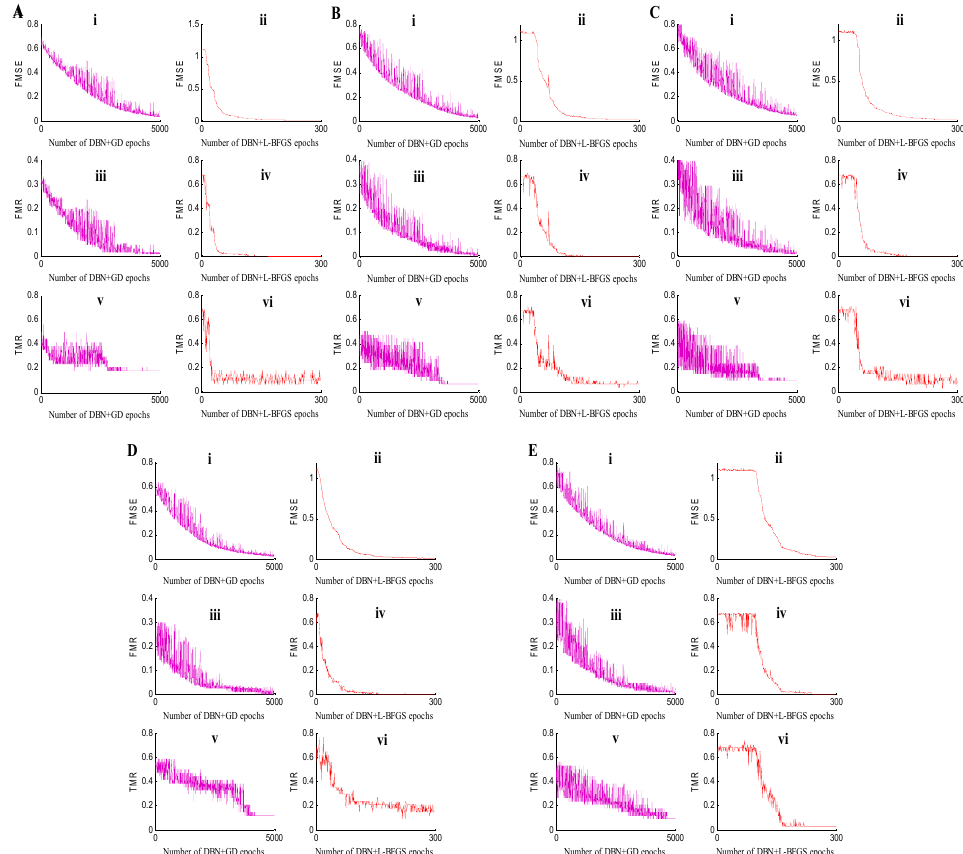
Figure 2. Fine-tuning experimental results on the five-fold data sets. In each subgraph of ( A ) to ( E ), (i) is the fine-tuning error mean square error (FMSE) of DBN+GD+Softmax, (ii) is the fine-tuning misclassification rate (FMR) of DBN+GD+Softmax, (iii) is the test misclassification rate (TMR) of DBN+GD+Softmax, (iv) is the fine-tuning error MSE (FMSE) of DBN+L-BFGS+Softmax, (v) is the fine-tuning misclassification rate (FMR) of DBN+L-BFGS+Softmax, and (vi) is the test misclassification rate (TMR) of DBN+L-BFGS+Softmax.